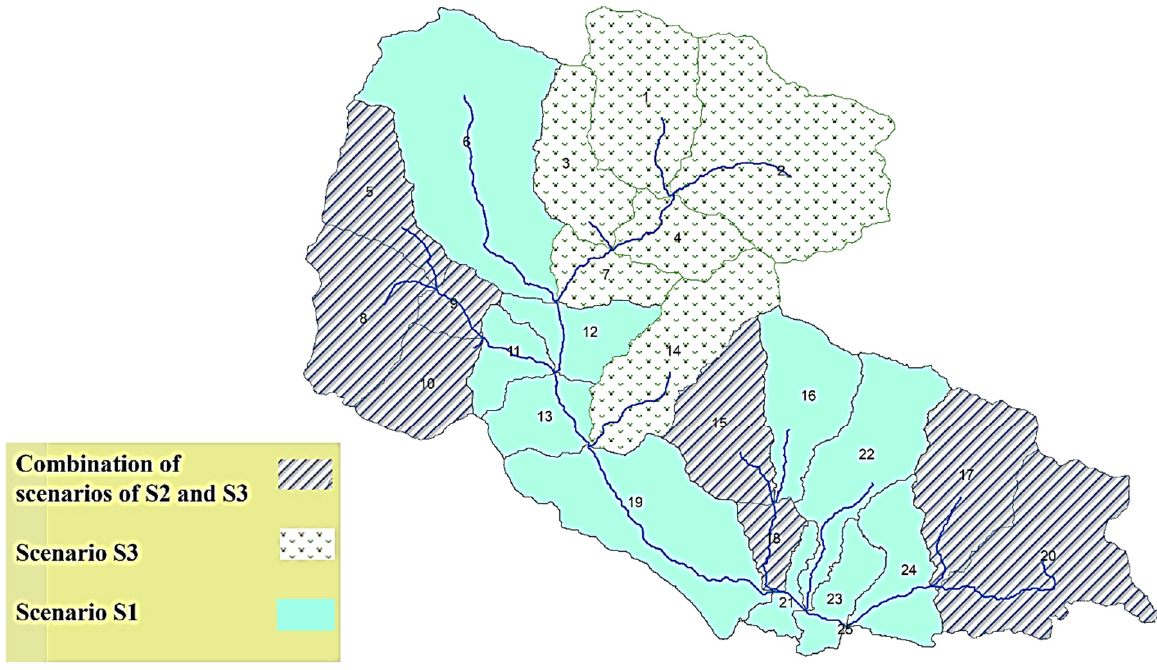
Figure 8. The types and locations of optimal BMPs.